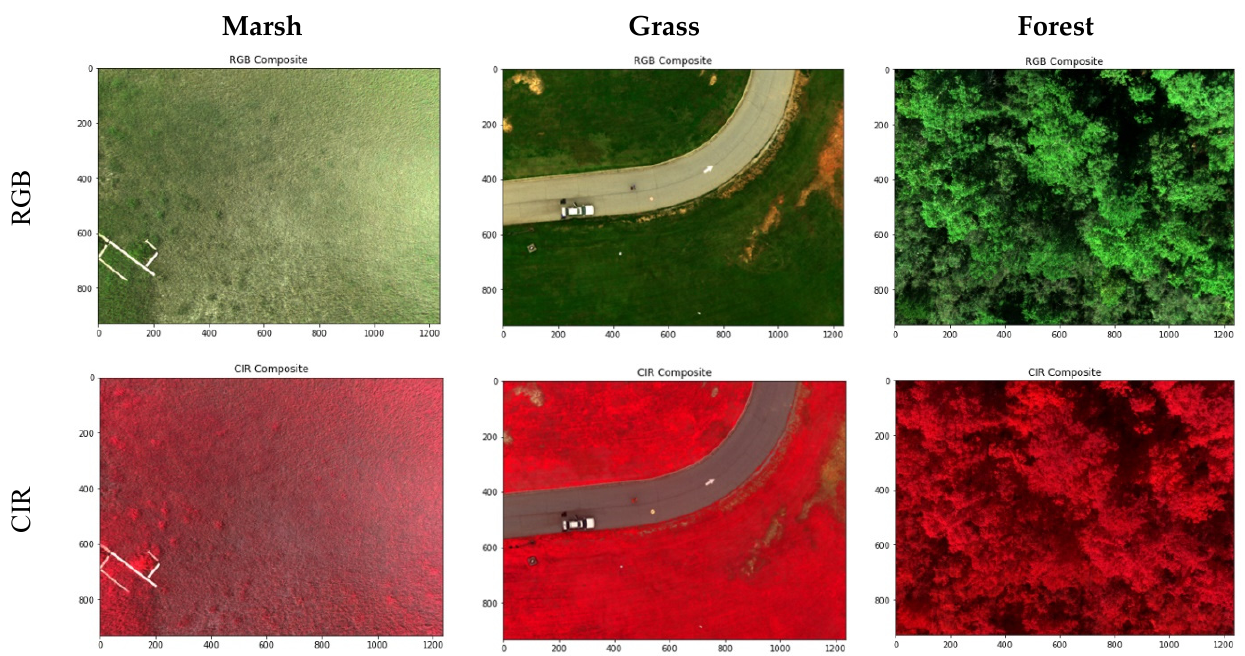
Figure 8. The normalization enhanced RGB and CIR composites of marsh, grass, and forest. The CIR is known to better reflect vegetation healthiness conditions in a reddish